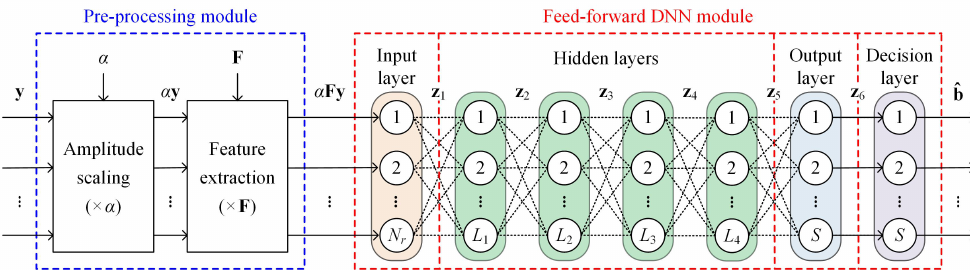
Figure 2. Schematic diagram of the proposed CSI-free DNN detector consisting of a preprocessing module and a feedforward DNN